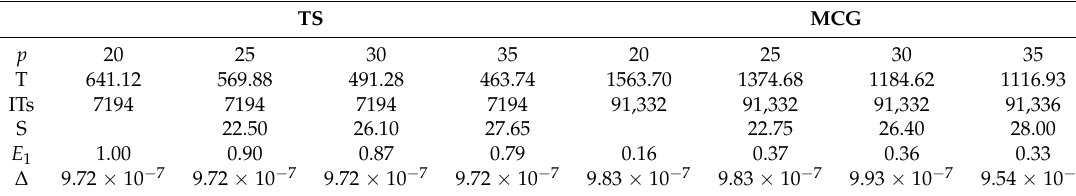
Table 6. Numerical results of Example 2 with h = 1/1001.